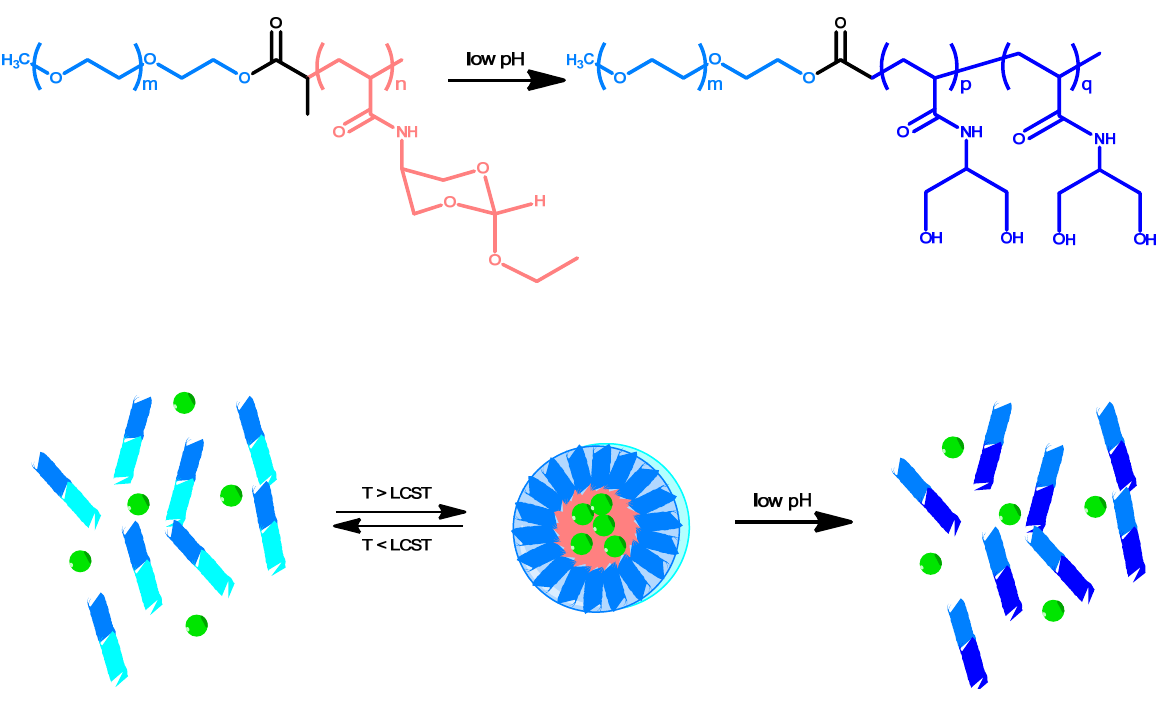
Figure 6. Thermally induced formation and acid-triggered dissociation of polymeric